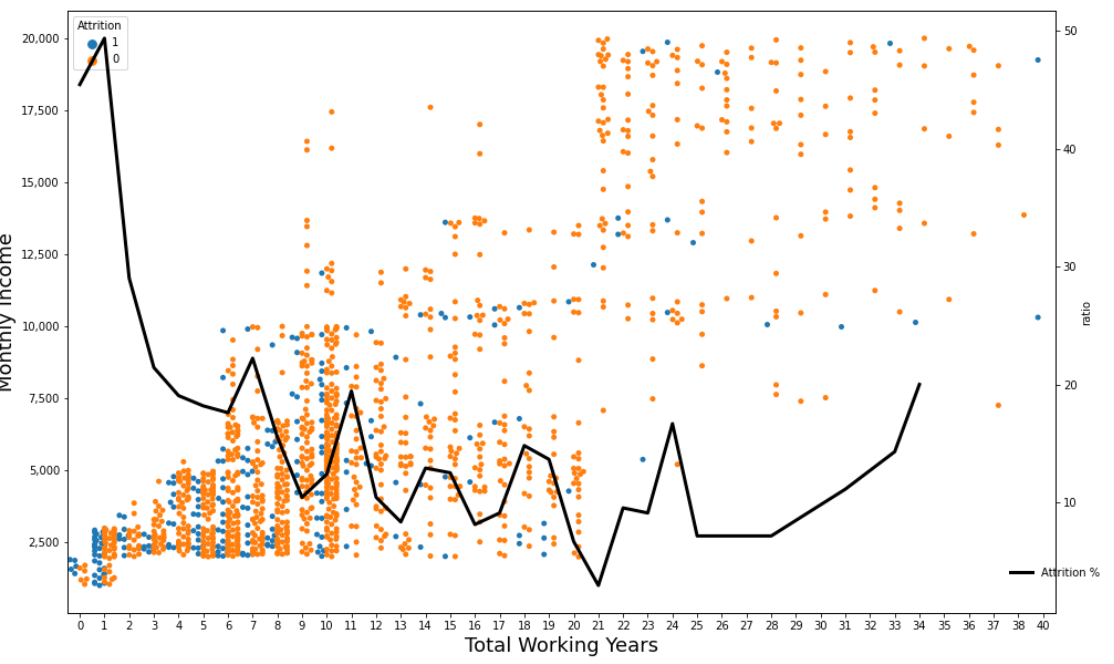
Figure 2. The total working years and monthly income data distribution analysis by employee attrition.